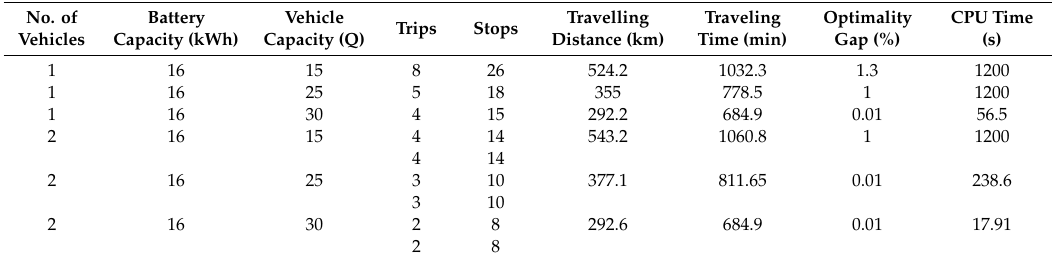
Table 14. The optimal solutions under di ff erent vehicle capacities ( Q k